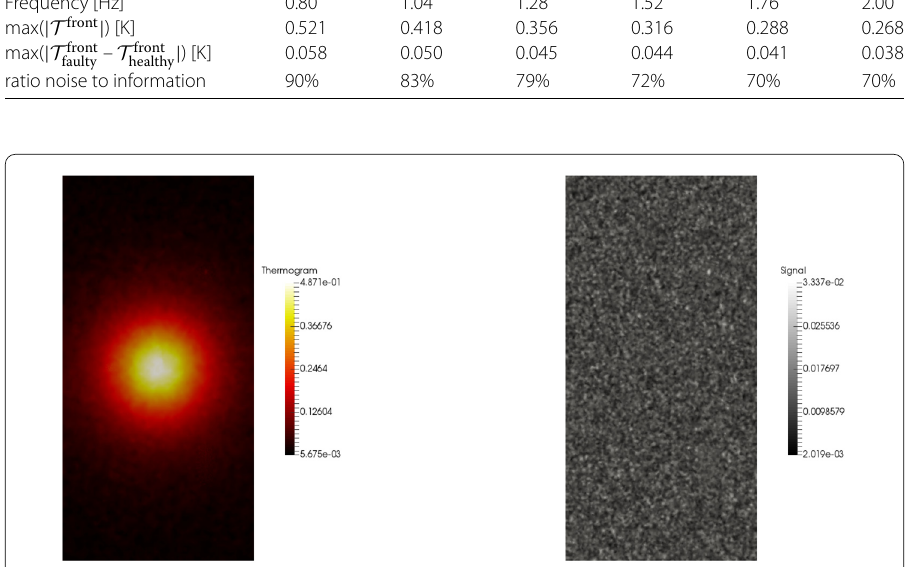
Figure 5 Thermograms with ω = 0.8 Hz. Left: amplitude of the temperature | T front | . Right: difference between thermograms corresponding to a healthy plate and a faulty one. At low frequencies defect detection is impossible at plain